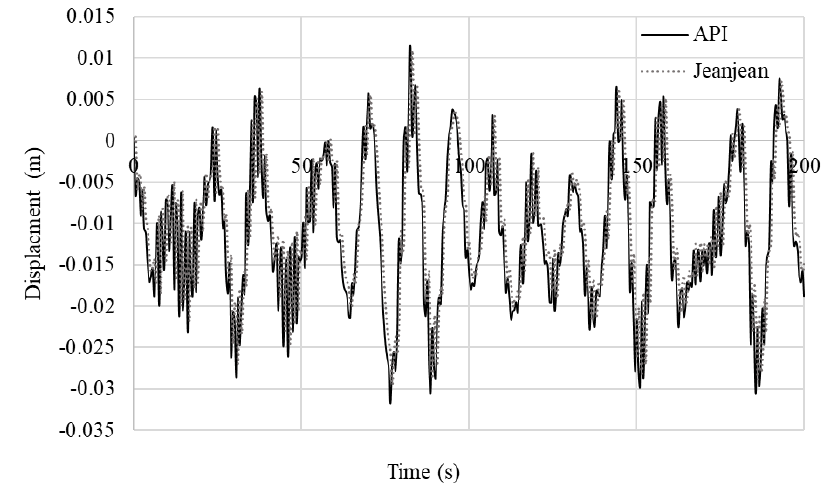
Figure 23. Comparison of the displacements in the y-direction of the jacket foundation resulting from two methods of nonlinear soil stiffness models.